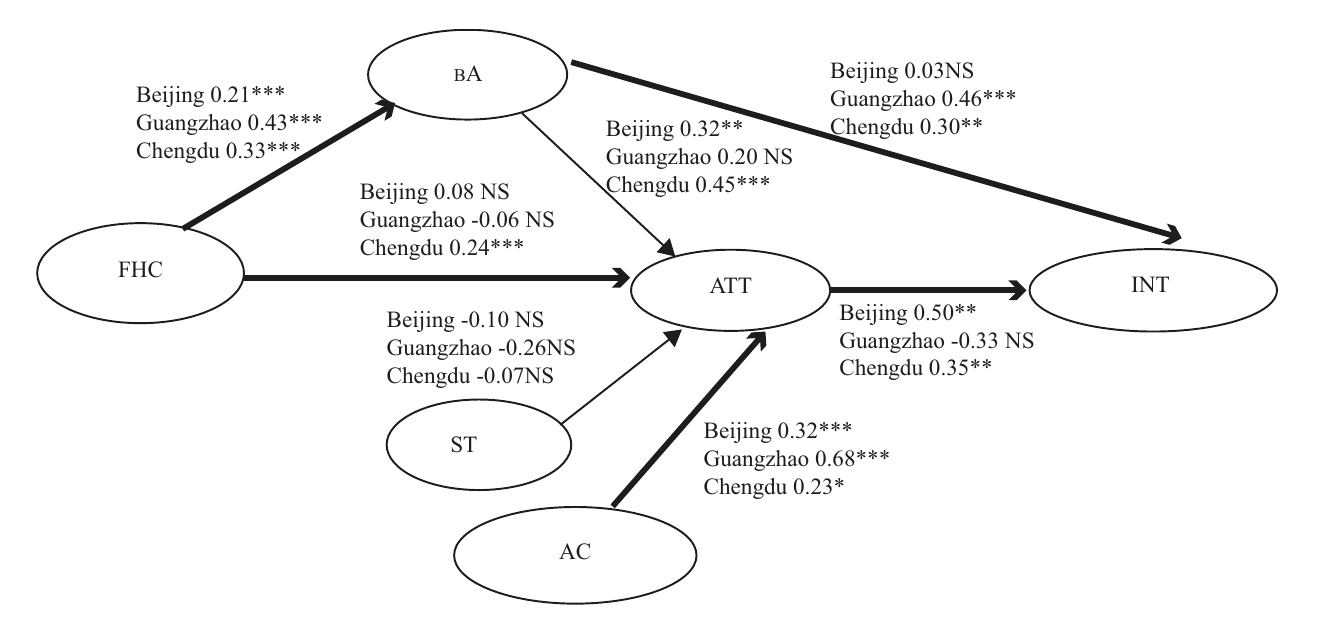
Fig 2. Structural paths and multi-group analysis.